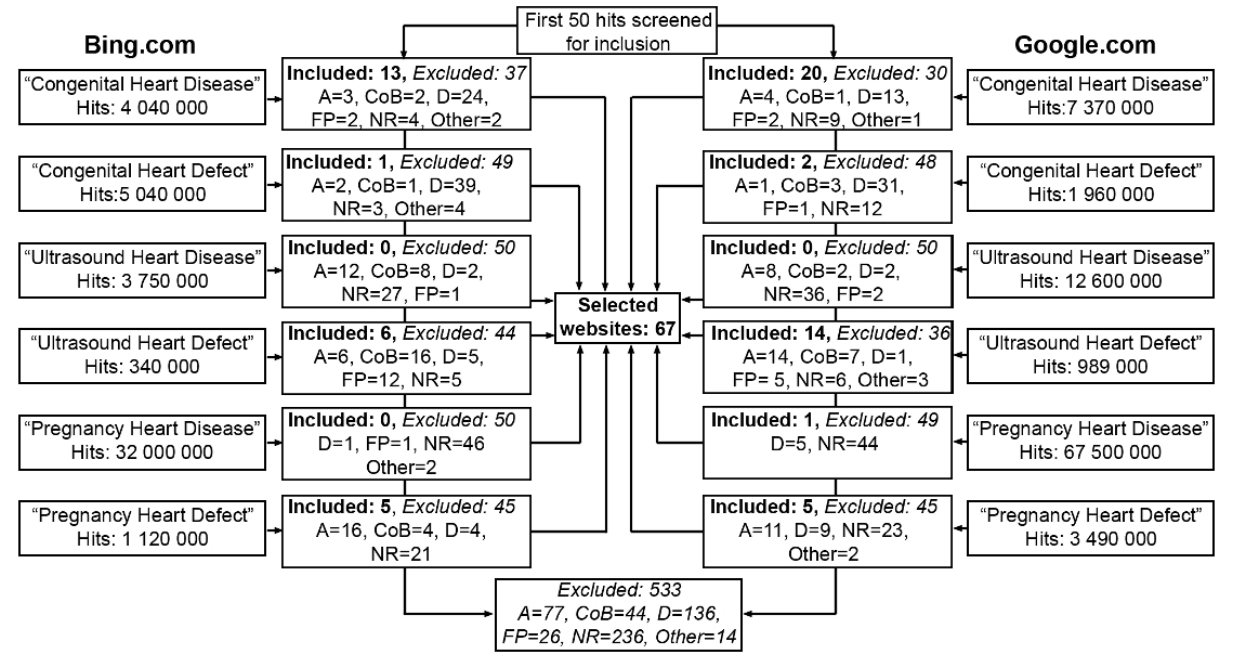
Figure 1. Selection process for the included websites (N=67; A: Scientific Article; CoB: Community or Blog; D: Duplicate; FP: For Professionals; NR: Not